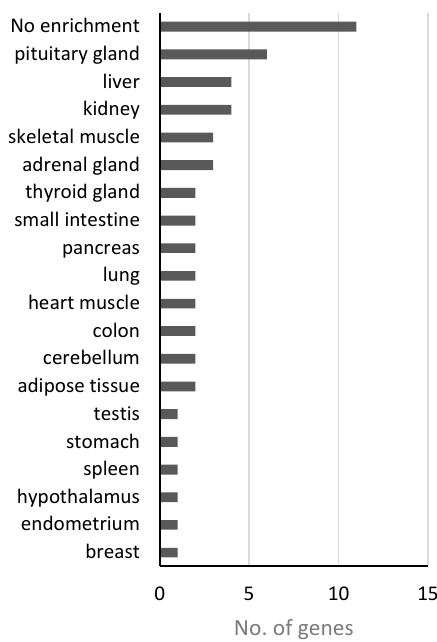
Figure 4. Gene expression enrichment in tissue/organ of 38 “endocrine”-class genes based on GTEx.